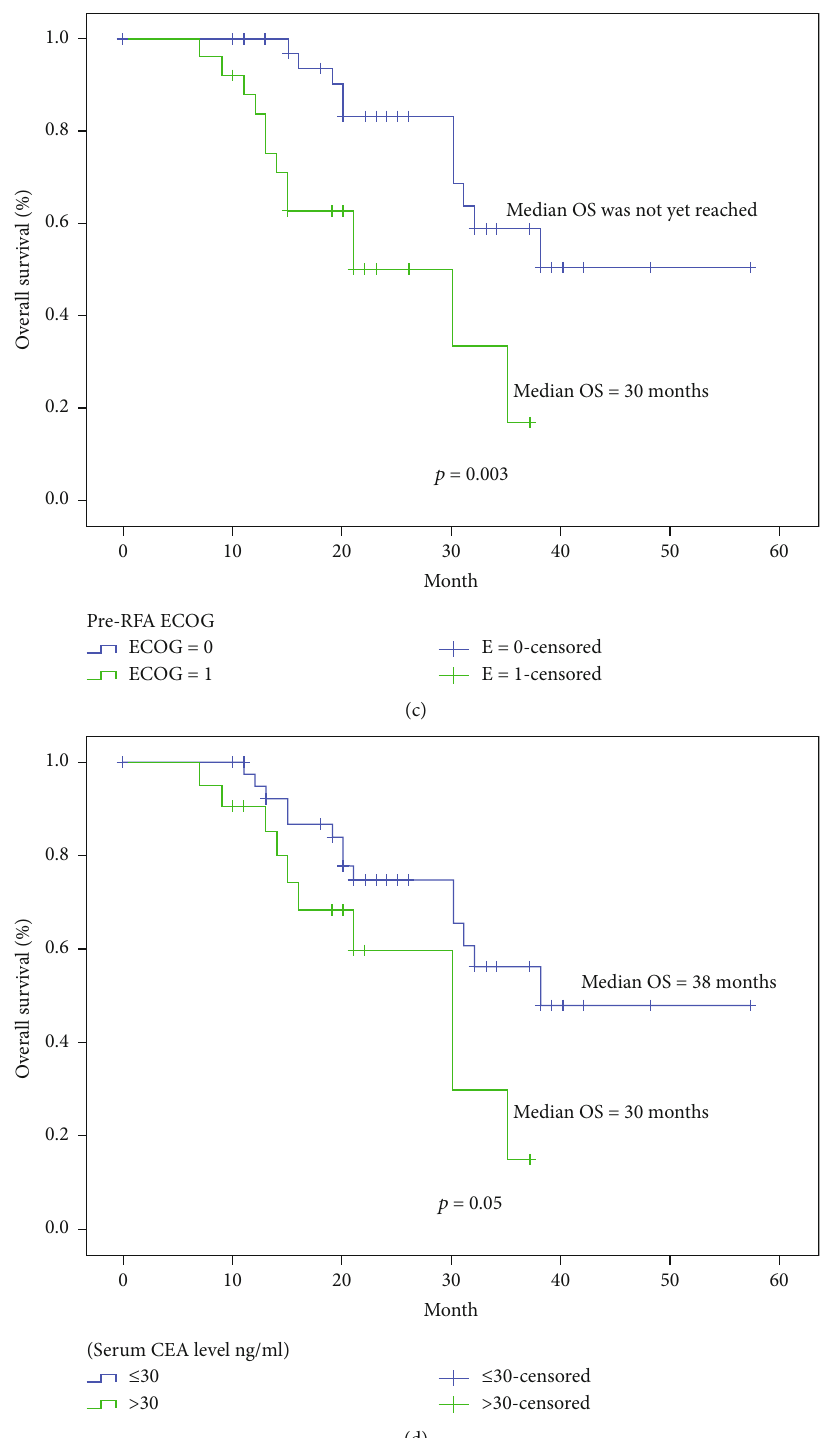
Figure 1: Survival rate subgroup analysis based on number of lesions in the liver (a), size of the largest liver lesion (b), ECOG status (c), pre- RFA serum CEA status